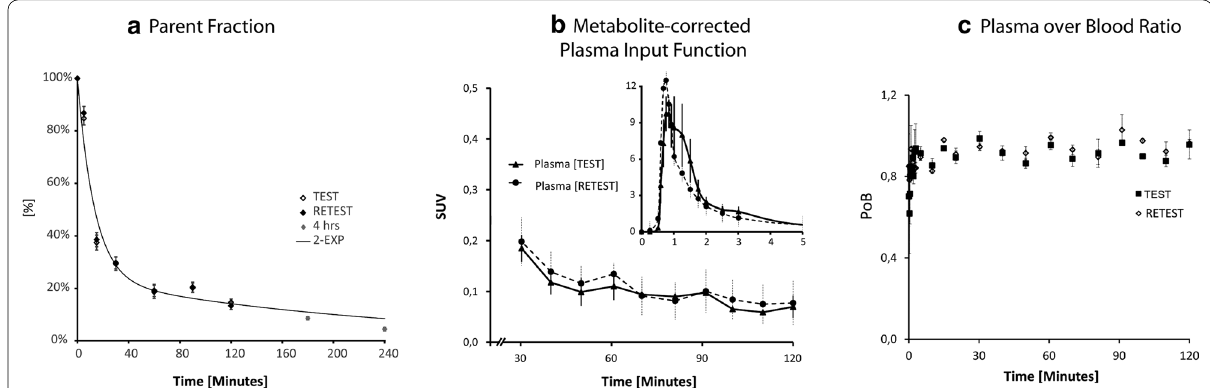
Fig. 1 Blood measures after i.v. [ 18 F]UCB-H injection in the cynomolgus NHP in test- and retest studies. Parental fraction (in %) was fitted with a two-exponential decay function based on blood data acquired up to 4 h after tracer injection ( a ). Average ( input function ( b ) and plasma to whole blood ratio ( c ) were highly consistent between and within animals